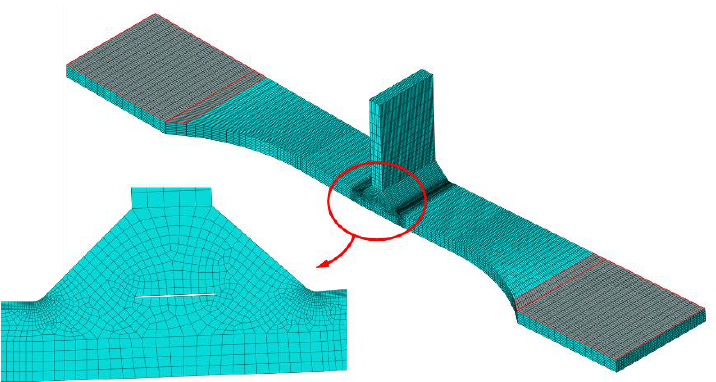
Figure 10. Numerical model with effective area of the clamping jaws.